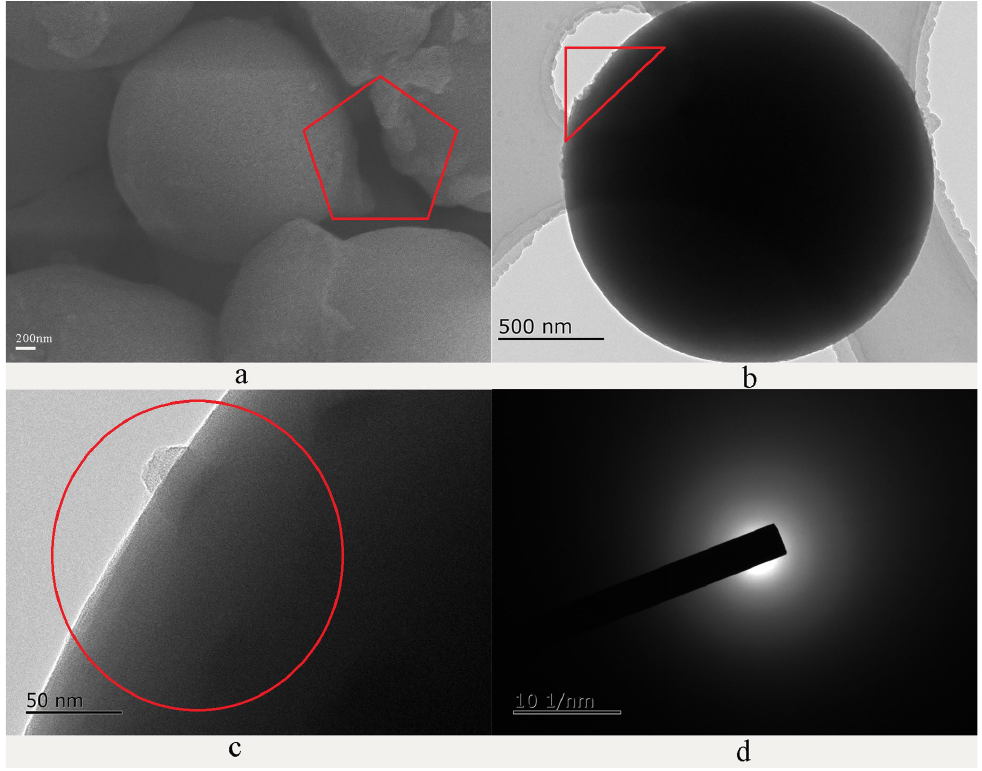
Figure 2. The microtopography of HCNP microsphere. ( a ) The SEM image of HCNP, ( b – d ) the TEM images of HCNP.